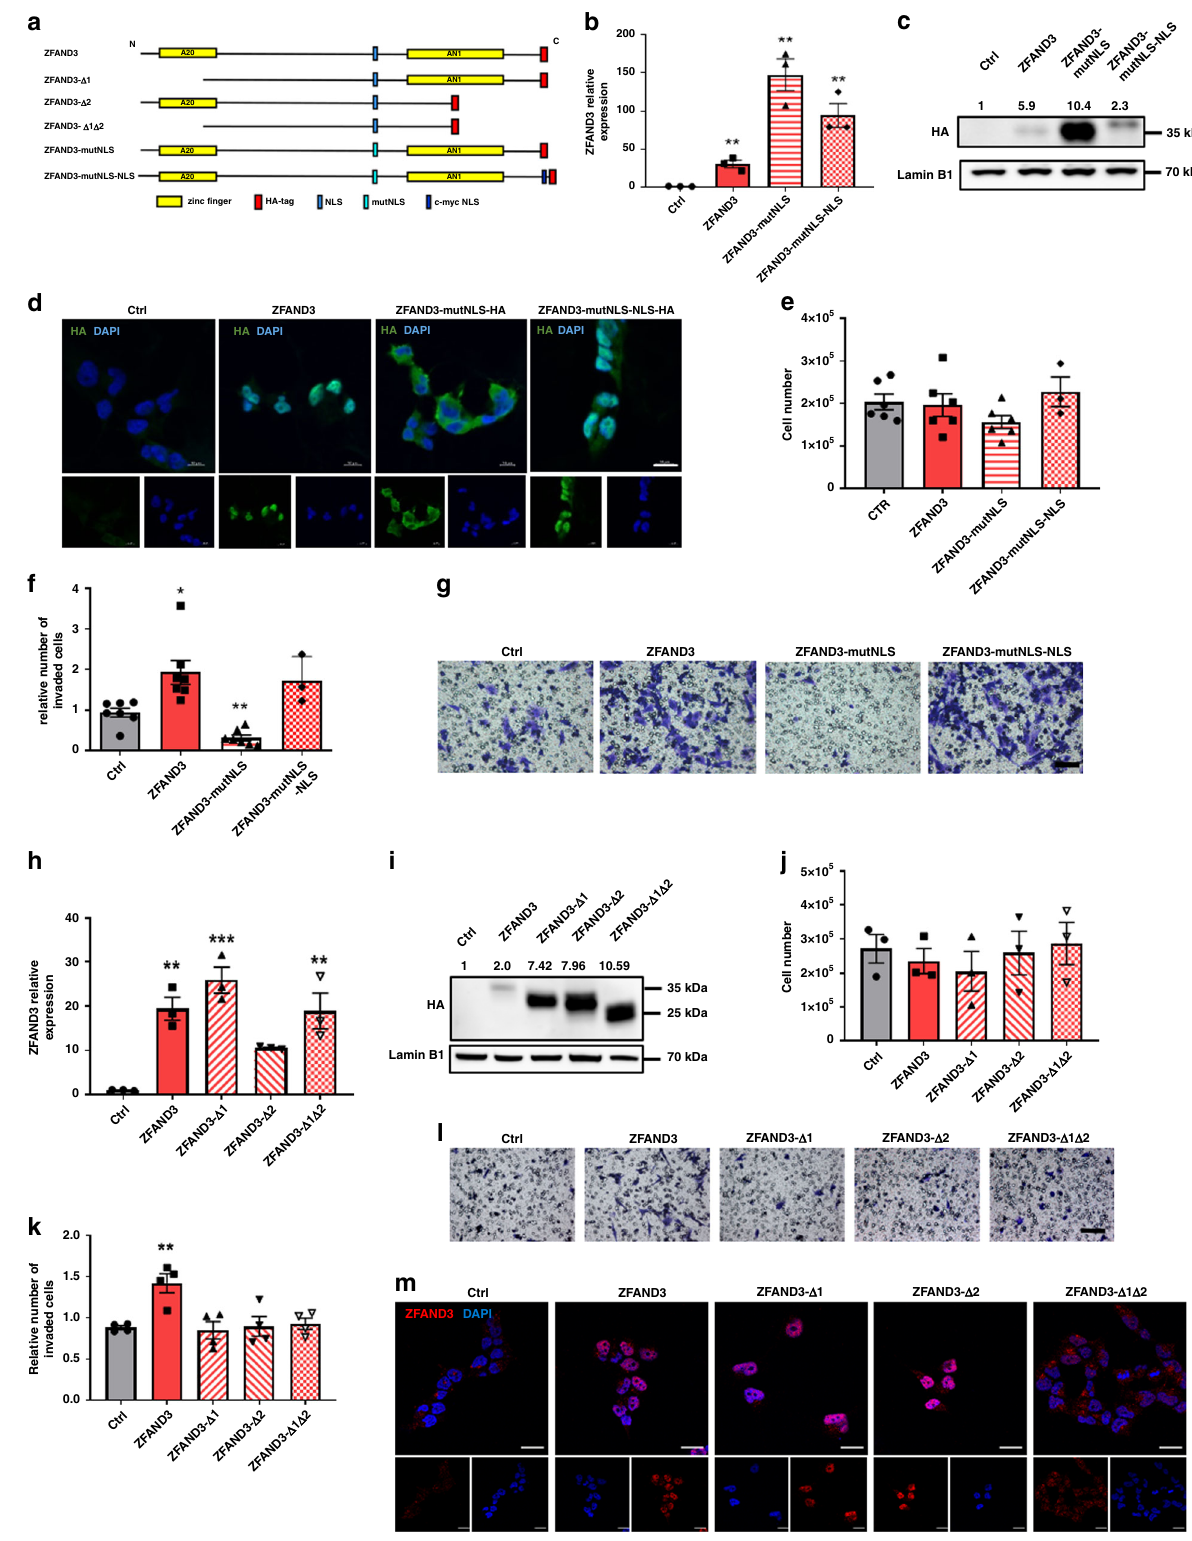
143 signi fi cantly enriched proteins in ZFAND3-BirA cells compared this, we interrogated the ZFAND3 neighboring interactome, using to control (adj. p value < 0.05, FC > 2) (Fig. 6j). Gene ontology the BioID screening technology 27 . Brie fl y, we expressed ZFAND3 analysis indicated candidate interactors to be involved in RNA fused with a biotin ligase (ZFAND3-BirA) in GSCs, which allowed regulation and transcriptional processes (Fig. 6k, Supplementary the biotinylation of proteins in close proximity (~10 nm) (Fig. 6i). Fig. 7c), reinforcing our hypothesis. To validate these results we After streptavidin-based puri fi cation, biotinylated proteins were performed ZFAND3-FLAG coimmunoprecipitation (FLAG Co-IP) analysed by mass spectrometry, and statistical analysis revealed NATURE COMMUNICATIONS| (2020) 11:6366